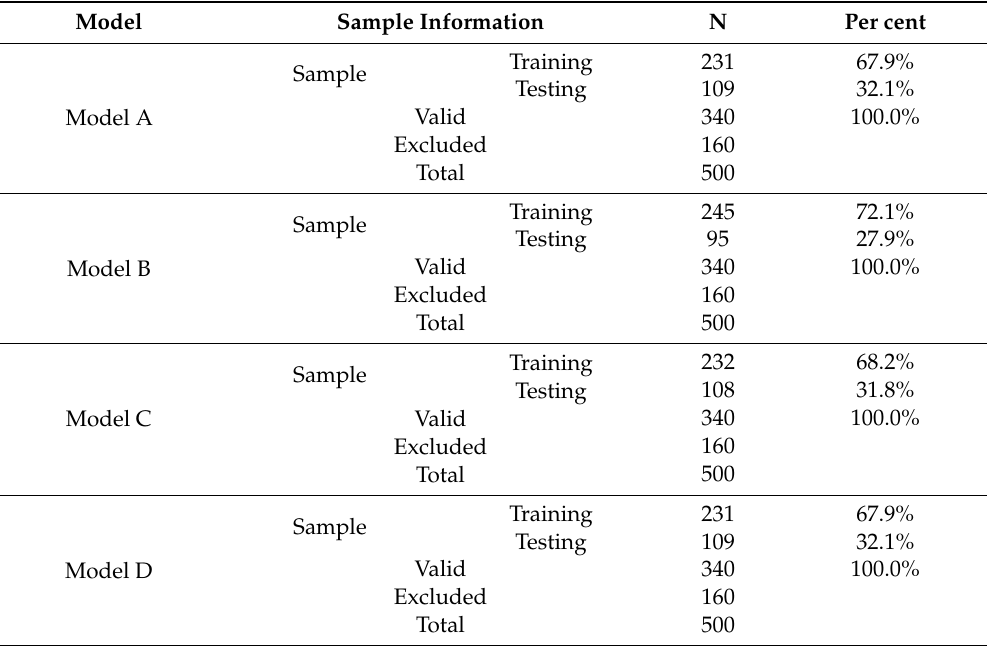
Table A1. Case processing summary (calculated by